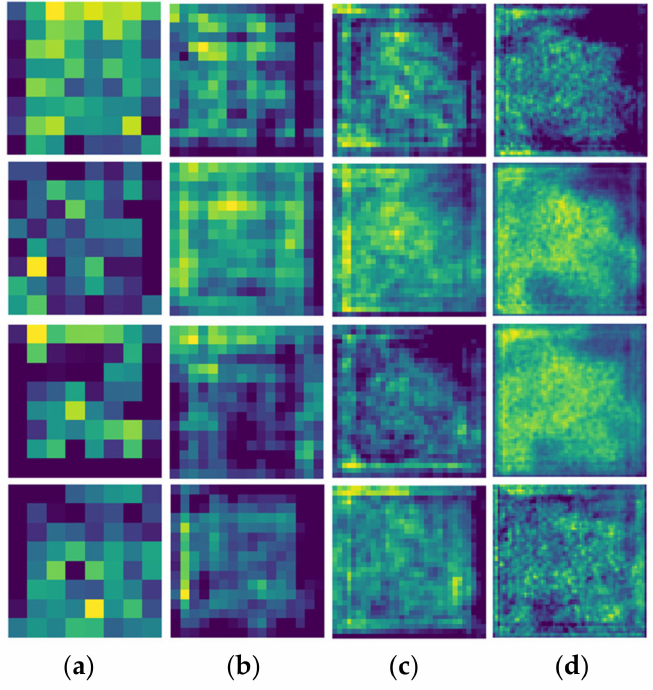
Figure 16. The visualization of the four resolution stage’s feature maps in decoding part of the model proposed in Figure 8: ( a ) input of the first up-sampling layer; ( b ) input of the second up-sampling layer; ( c ) input of the third up-sampling layer; ( d ) input of the fourth up-sampling layer. Each column represents a random selected kernel within the corresponding up-sampling